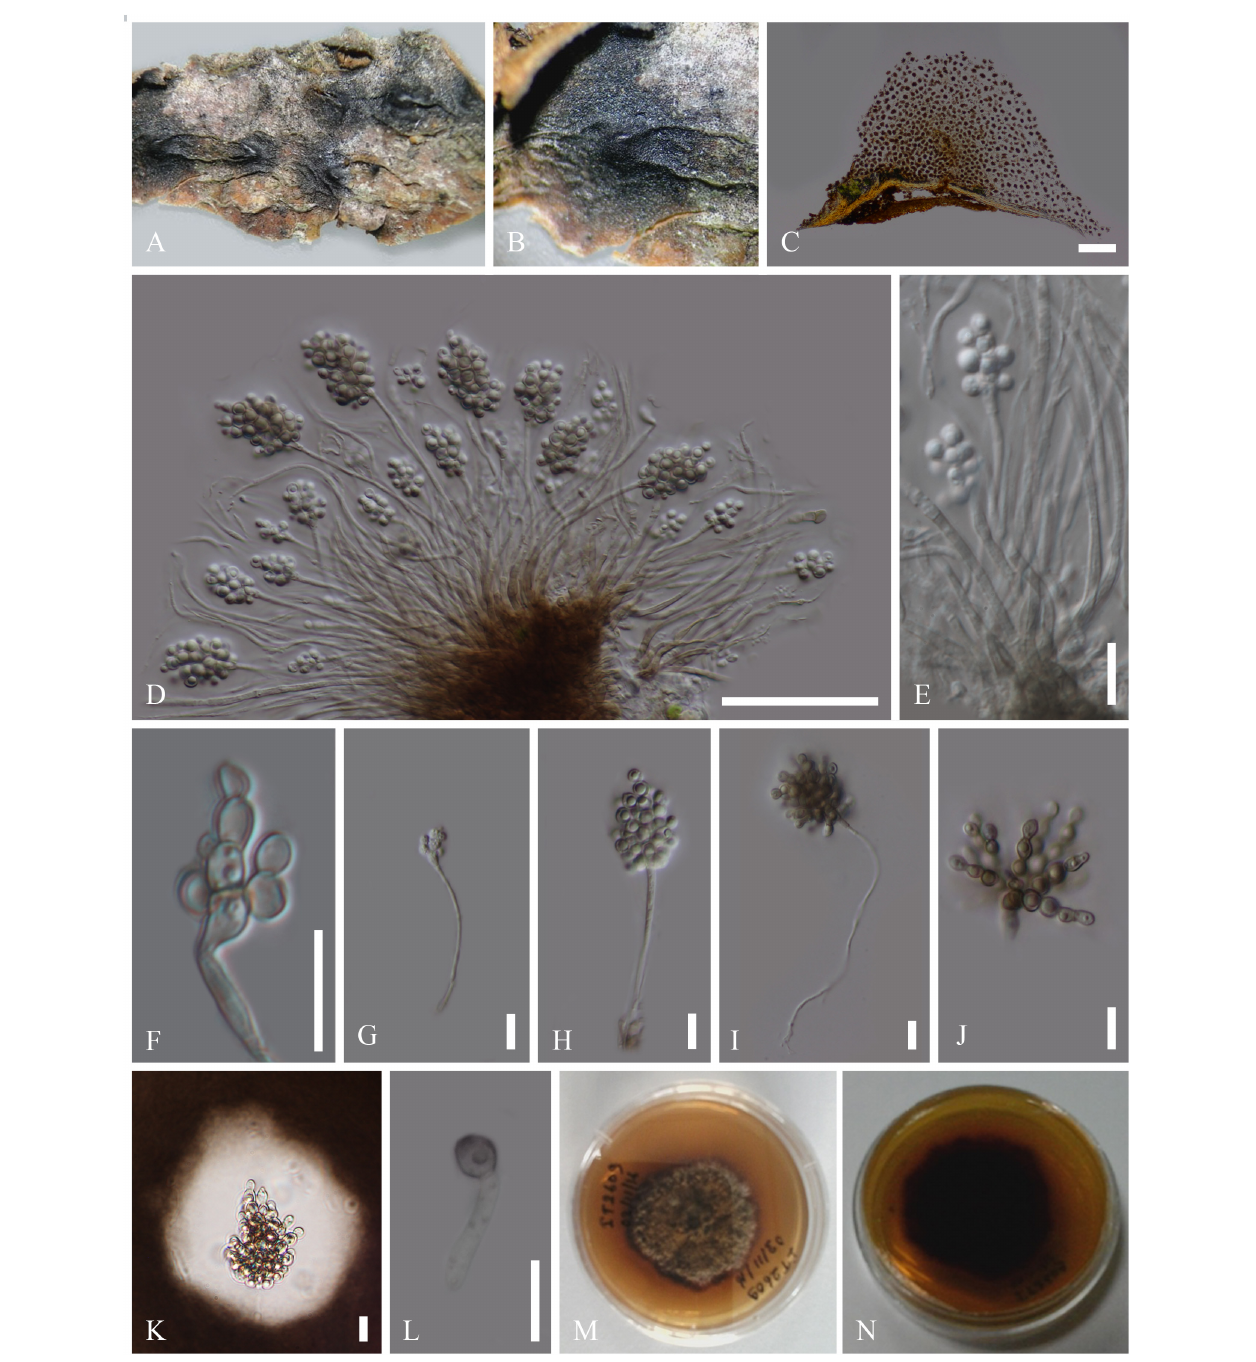
FIGURE 3 | Asexual morph of C. botryospora (MFLU 15-2612). (A,B) Appearance of sporodochium on host substrate. (C) Longitudinal section of sporodochium. (D,E) Conidia attached to the conidiophores. (F–J) Conidia. (K) Conidia surrounded by mucilaginous sheath, stained with Indian ink. (L) Germinated conidium. (M,N) Culture characteristics on PDA ( M = From above, N = From below). Scale bars: C = 20 µ m; D,E = 50 µ m; F–J = 10 µ